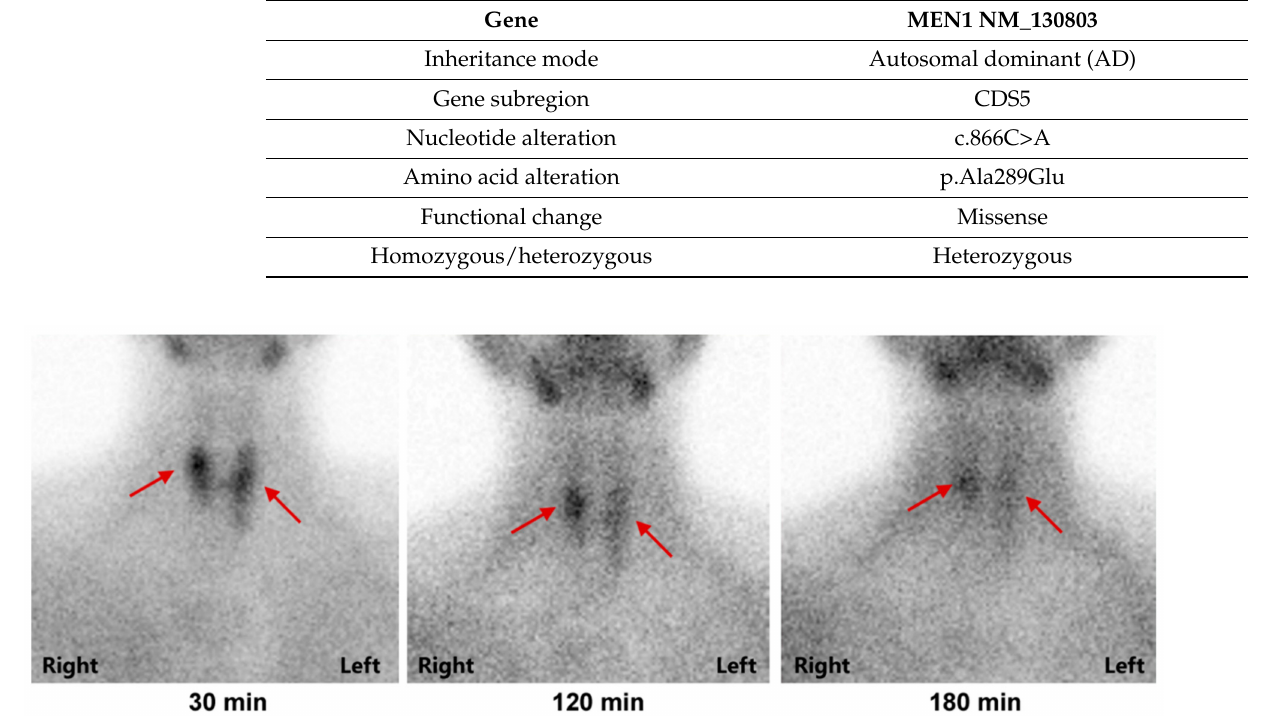
Figure 2. The image of the parathyroid glands in 99mTc MIBI scintigraphy; MIBI accumulation was observed at 120 min as well as at 30 min in neck lesion which was thought to be parathyroid lesion (arrows in both panels). Gastrin levels returned to normal after surgery, and the patient took Esomeprazole 20 mg/d for 7 years, with regular follow-up. The latest reexamination showed a gradual increase in his serum calcium. The latest albumin-corrected serum calcium was 2.63 mmol/L (reference ranges, 2.11–2.52 mmol/L), serum phosphorus level was 0.72 mmol/L (reference ranges, 0.85–1.51 mmol/L) and PTH level was 141 pg/mL (reference ranges, 11.0–67.0 pg/mL). Parathyroid gland ECT indicated a slight increase of delayed uptake tracer in the right middle and upper pole of the thyroid, left middle and upper pole of the thyroid, and left lower pole of the thyroid, suggesting possible parathyroid origin (Figure 2). Dual-energy X-ray examination suggested osteoporosis (T value of left femoral neck −